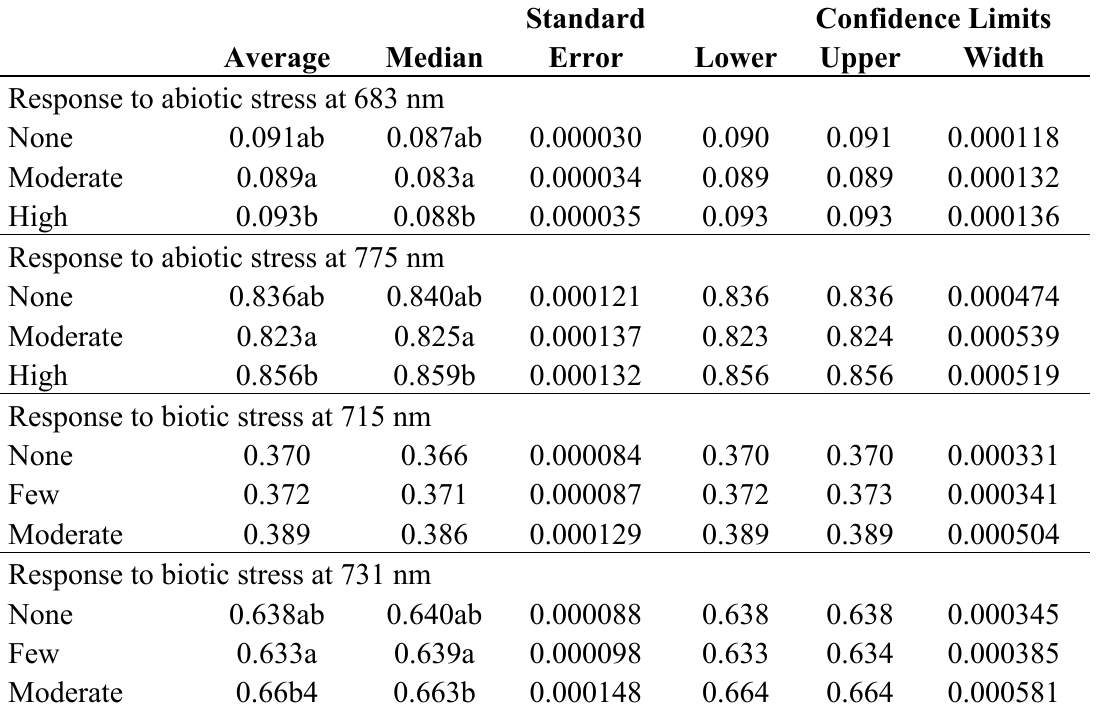
Table 2. Descriptive statistics of average reflectance values at 683, 715, 731, and 775 nm. Standard Confidence